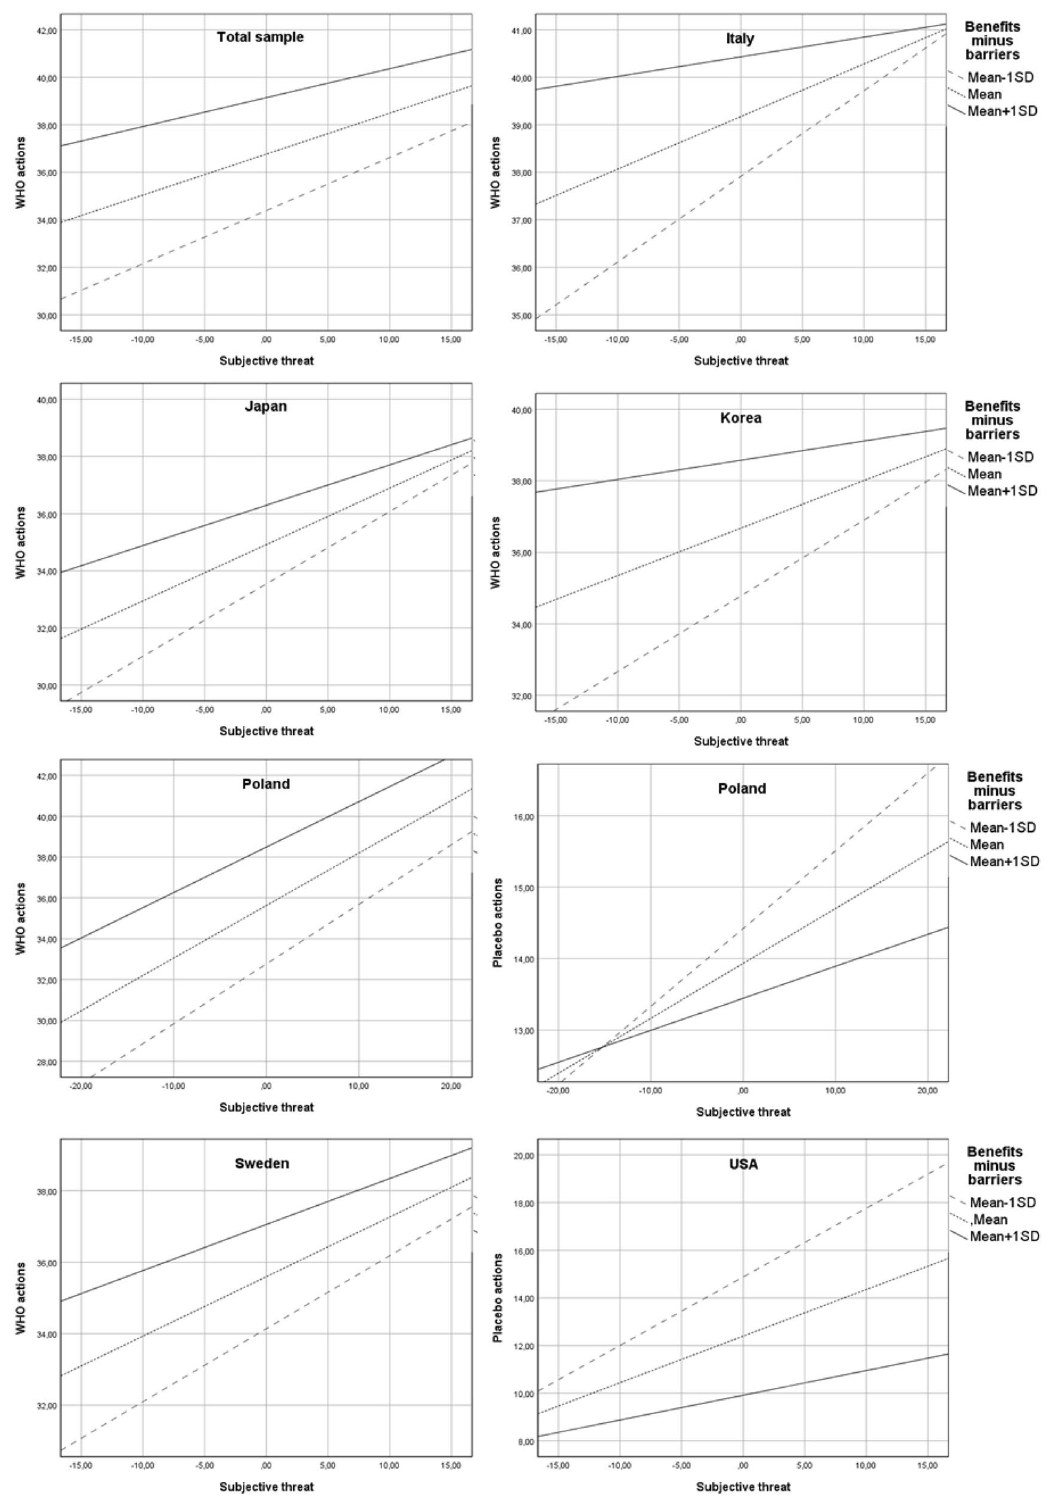
Figure 5. Simple slope analysis (hypothesis 2). Note: The interaction effect of subjective threat and decision balance (H2) was present in all of the analysed nations. However, in most cases this effect was confirmed only for one type of preventive actions and not the other. The only exception was Poland, where a significant interaction effect was found for both WHO-recommended actions and placebo actions. A reduced positive effect of perceived threat on frequency of both types of behaviours was observed among individuals who perceived more benefits than barriers associated with preventive actions. In the case of WHO-recommended actions, a similar effect was observed in Japan, Italy, Sweden and the Republic of Korea. In the USA, this effect was found only in the case of placebo actions. Total sample: N = 3346; Italy: N = 405, Japan: N = 190, Republic of Korea: N = 551, Poland: N = 1092, Sweden: N = 587, USA: N =